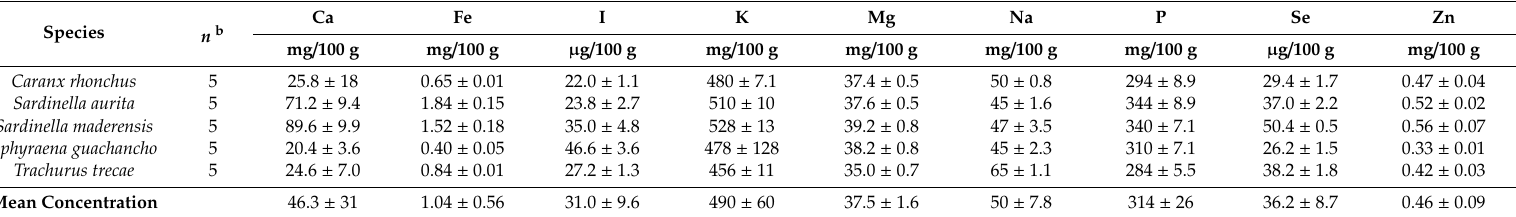
Table 4. Concentrations of minerals and trace elements in fish species from Angola a